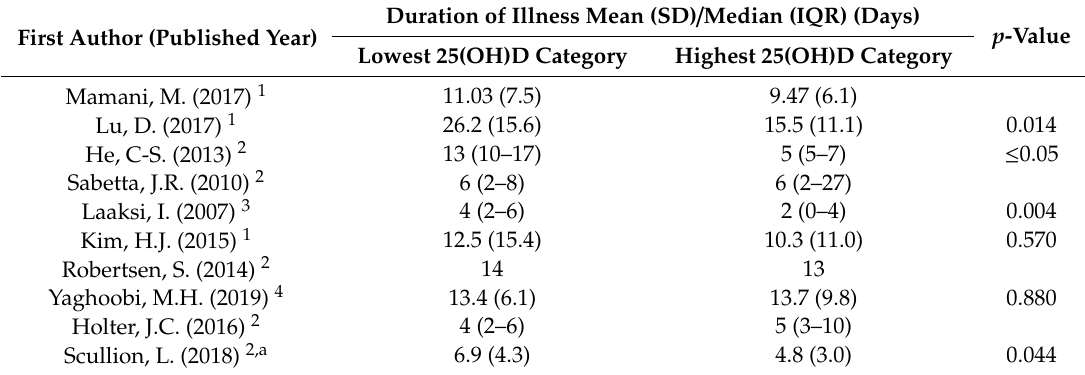
Figure 5. Forest plot displaying odds ratios (OR) and 95% confidence interval (95% CI) for the association between 25(OH)D concentration and (A) severe acute respiratory tract infection, and (B) mortality, comparing the lowest versus the highest 25(OH)D category. Table 3. Studies reporting duration of illness according to 25(OH)D concentration.